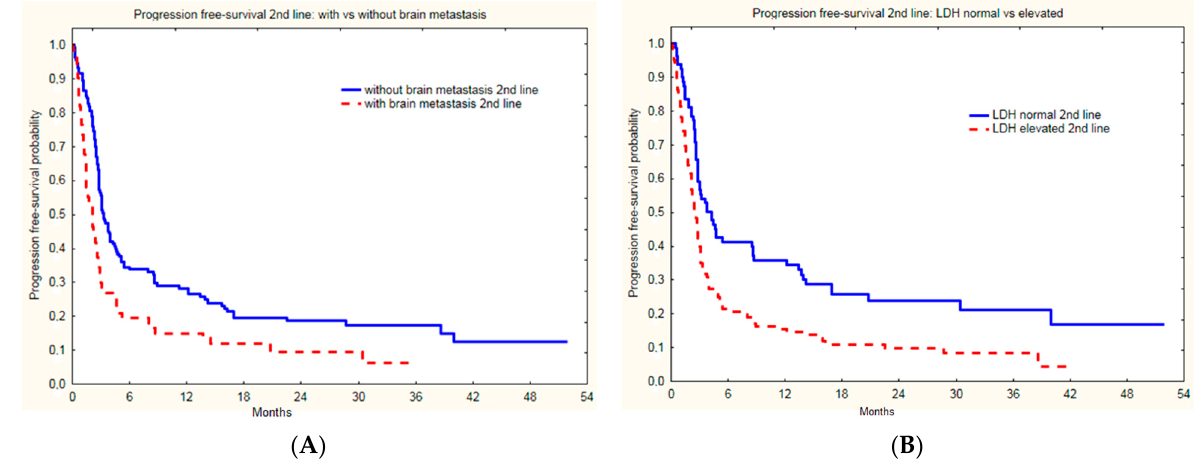
Figure 4. Progression free survival of melanoma patients with and without brain metastases ( A ) and normal and elevated LDH level ( B ) since initiation of second line immunotherapy.